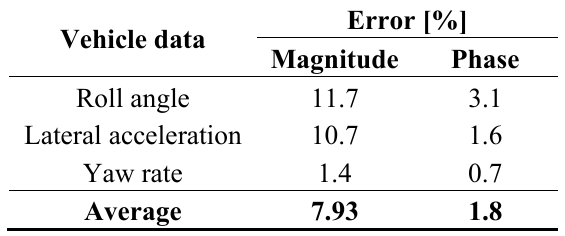
Table 1. Accuracy of simulation results compared with test